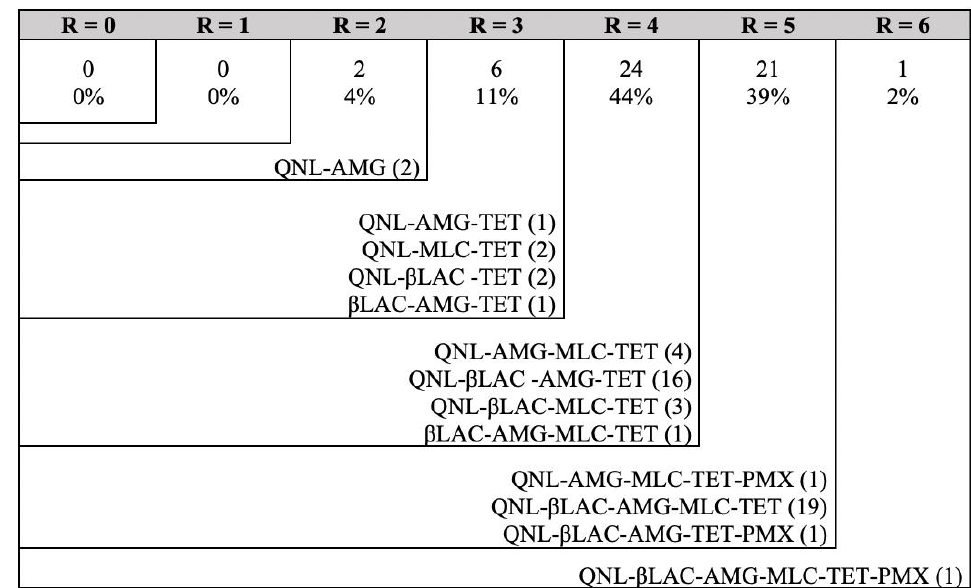
Figure 2. Patterns of resistance for C. jejuni isolates. R: number of antibiotic resistances; QNL: quinolones; AMG: aminoglycosides; TET: tetracycline; βLAC: β-Lactamases; MCL: macrolides; PMX: polymyxin. Number within parentheses: number of isolates with the indicated pattern.